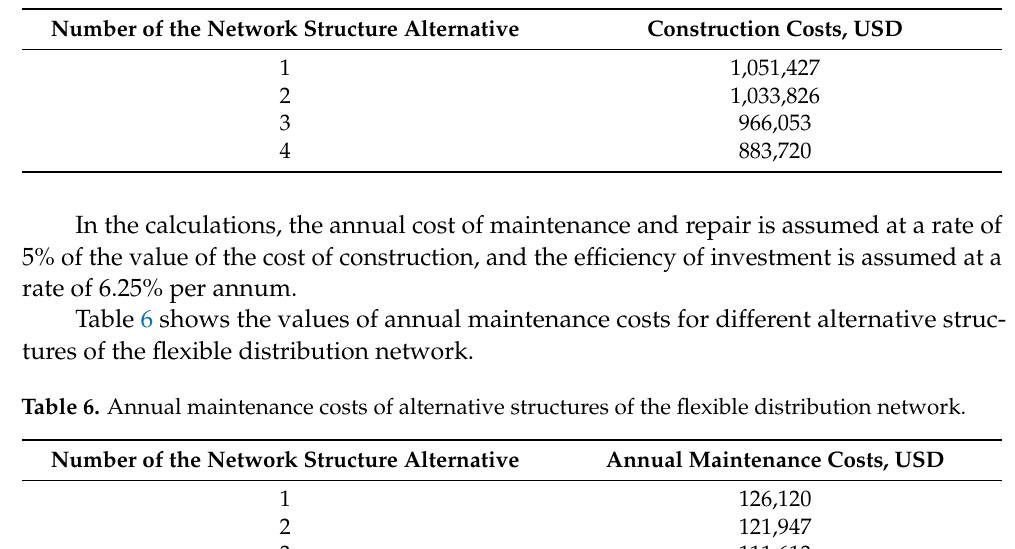
Table 5. The construction costs for alternative structures of the flexible distribution network.